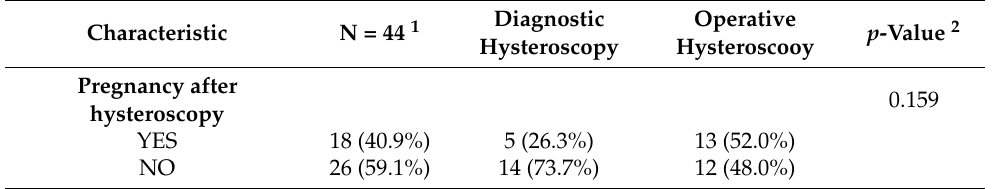
Diagnostic Operative p -Value 2 Hysteroscopy Hysteroscooy 0.159